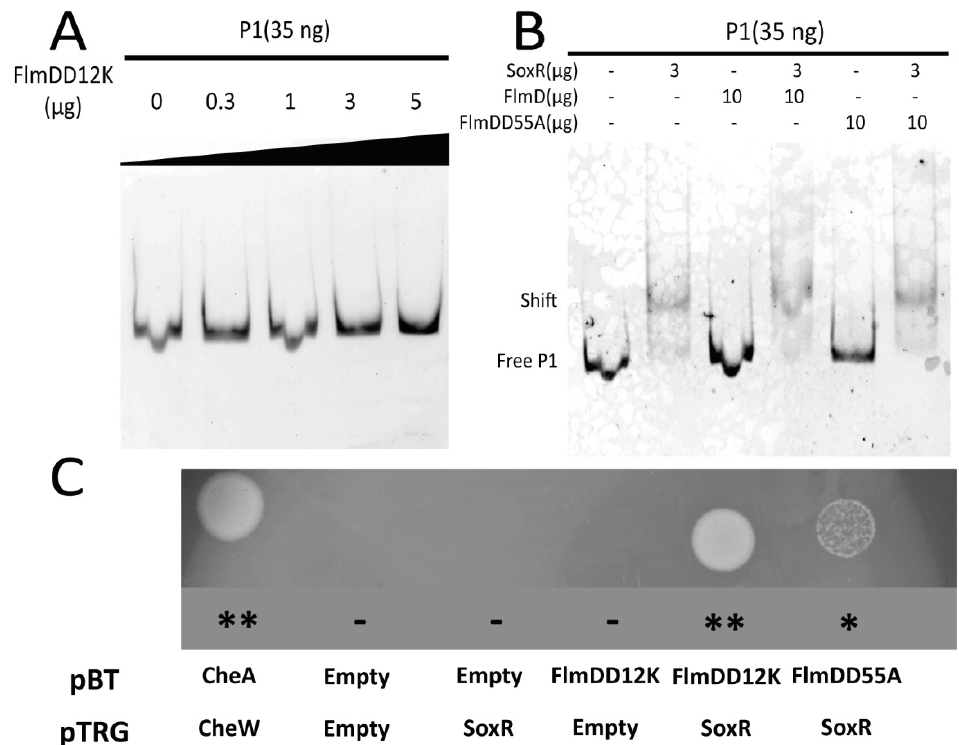
Figure 5. FlmD variant proteins interact with the transcriptional activator SoxR. ( A , B ) Interactions between FlmD/FlmD variants and the acrAB-tolC operon were assessed using the gel shift assay. Neither FlmDD12K nor FlmDD55A directly interacts with acrAB-tolC operon; ( C ) The bacterial two-hybrid system measured interactions between SoxR and FlmD variants. The growth of transformants is shown on selective screening medium plates. Better growth indicates a stronger interaction. The known interaction between CheA and CheW served as positive control. The asterisk and minus indicate the growth status. **: strong; *: weak; -: null.